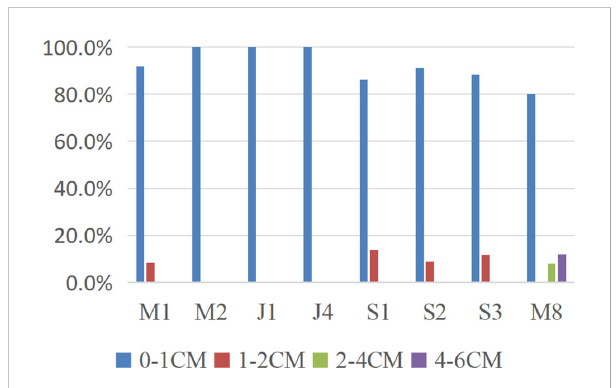
FIGURE 2 Vertical distribution of the marine tardigrade fauna. Percentage of specimens found in each sediment layer at different stations.